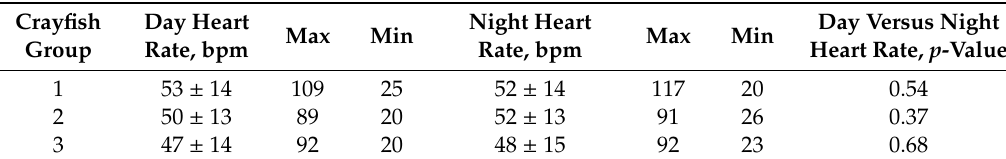
Table 2. Average heart rate expressed as beats per minute of all monitored crayfish from the three groups during the ClO 2 exposure period. Mean ± SD.